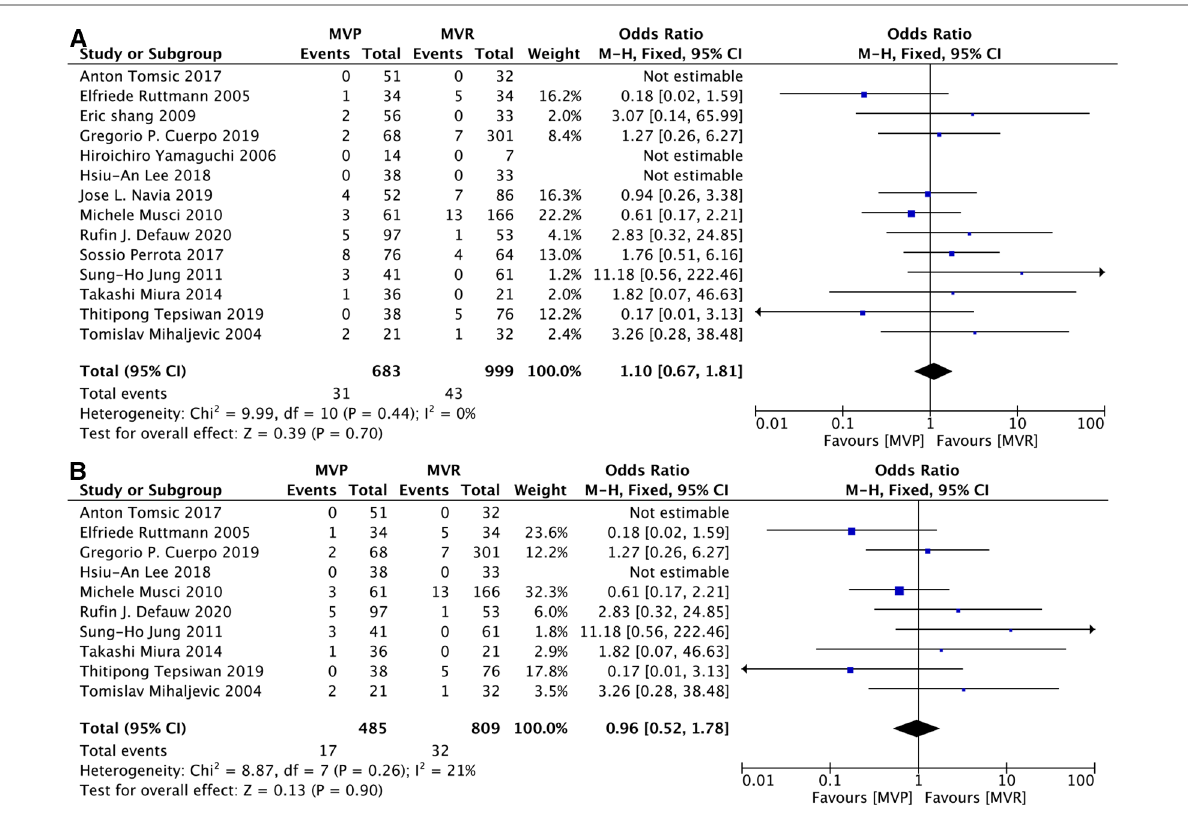
FIGURE 6 Meta-analysis for reinfection events between MVP and MVR; ( A ) MVP vs. MVR; ( B ) MVP vs. MVR (active IE); MVP, mitral valve plasty; MVR, mitral valve